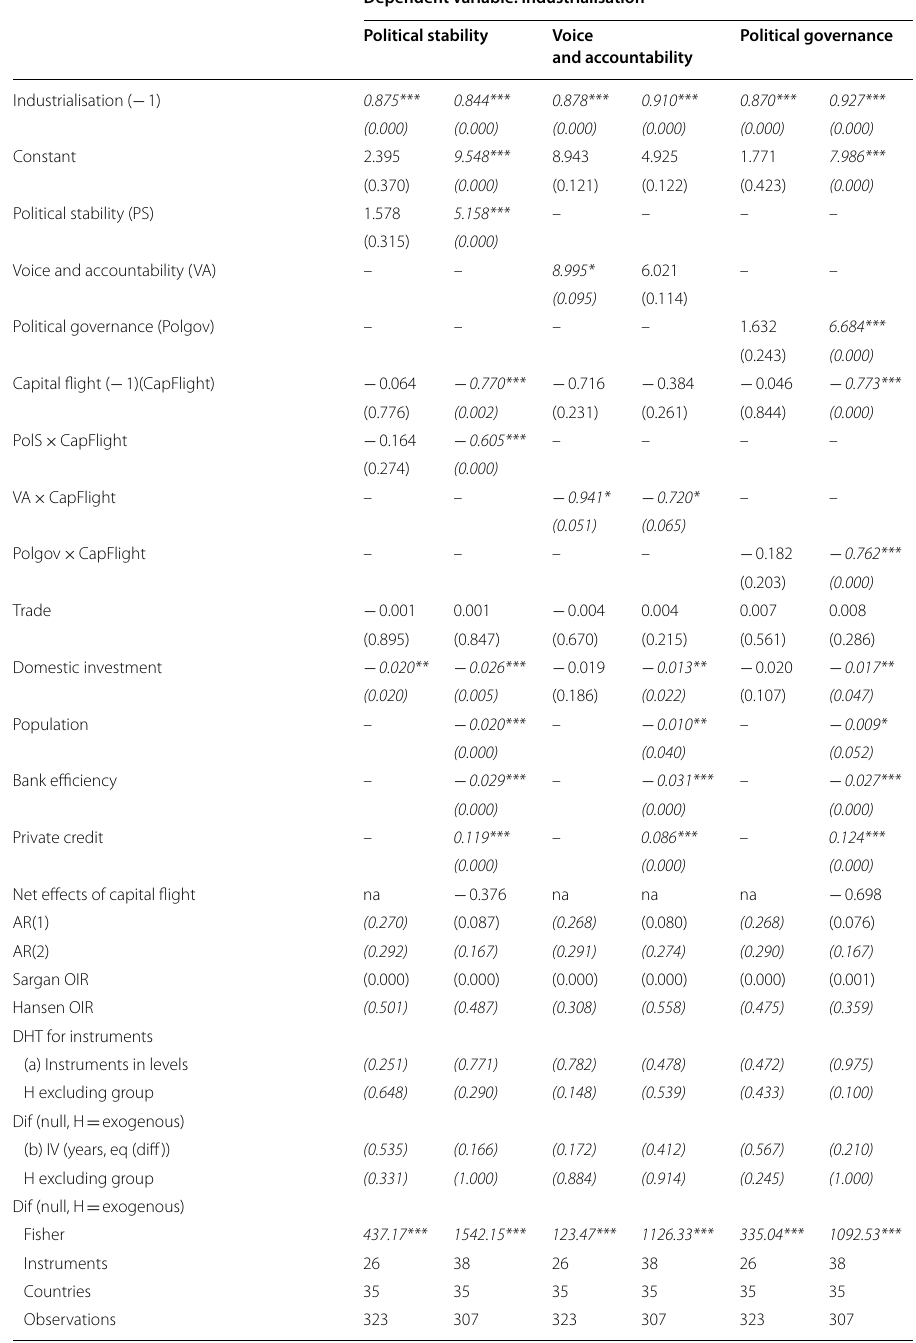
Table 2 Political governance, capital flight and